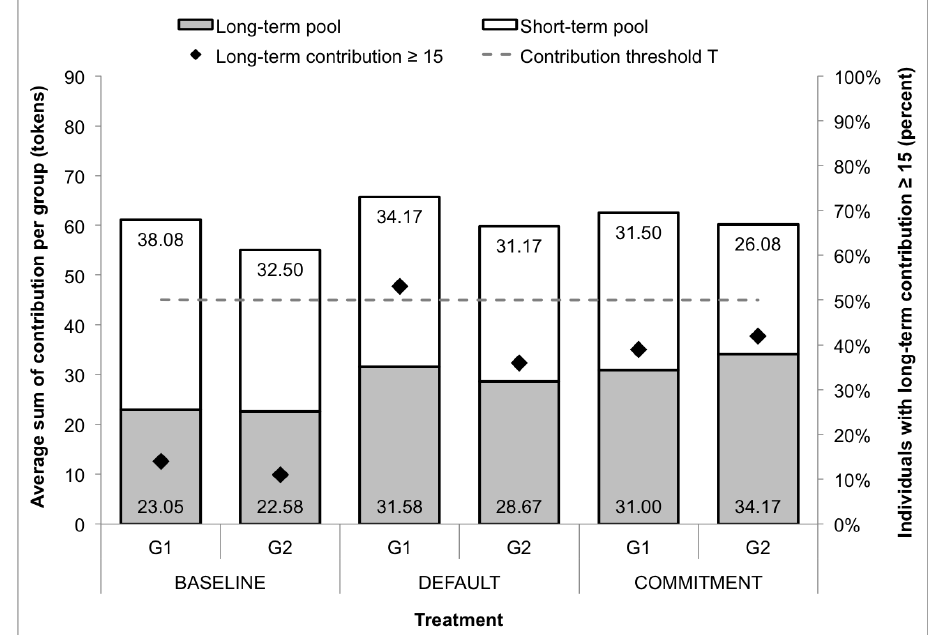
Figure 2. Average sum of contribution to the long-term pool (gray columns; left Y axis), to the short-term pool (white columns; left Y axis), and the contribution threshold T (gray dotted line; left Y axis), as well as individuals with a long-term contribution ≥ 15 (black diamonds; right Y axis) by treatment and generation.